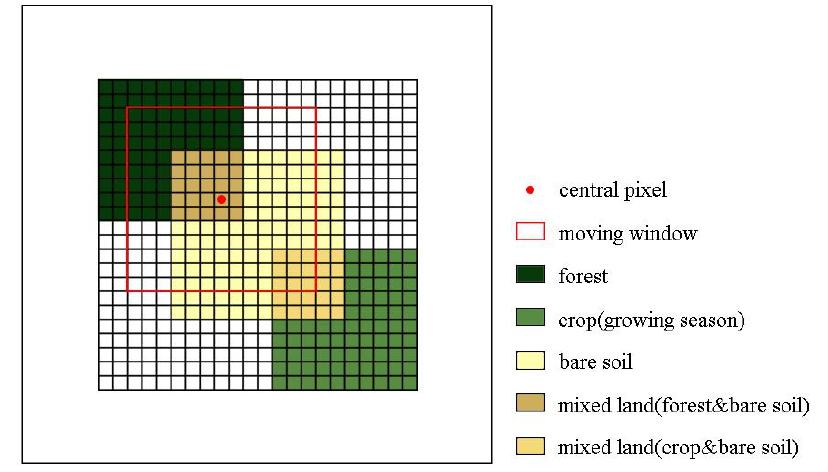
Figure 3. The simulated mixed pixels in Landsat data.